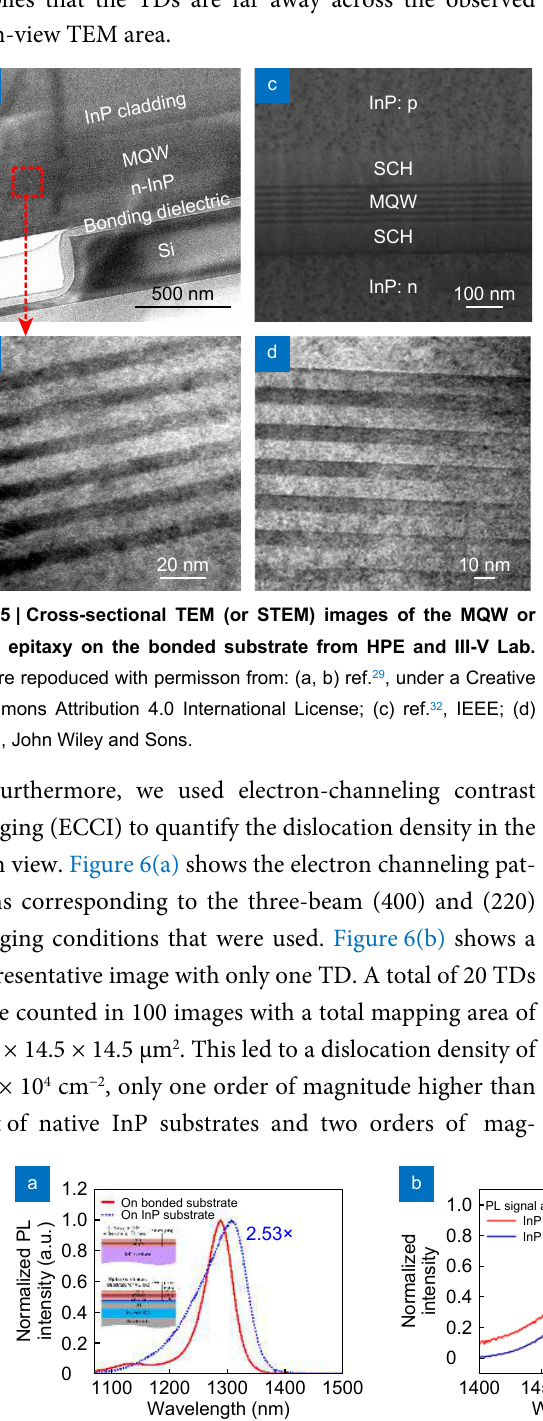
Fig. 7 | The PL measurements at room temperature for the epitaxy on both InP and the bonded substrate from HPE, III-V Lab and Sophia University. Figure repoduced with permisson from: (a) ref. 29 , under a Creative Commons Attribution 4.0 International License; (b) ref. 32 , (c) ref. 26 ,